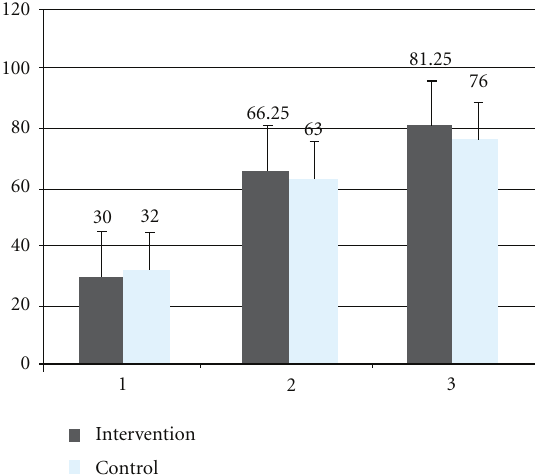
Figure 2: Mean Barthel index scale score at baseline, one month and six months of the intervention and control group. 1; baseline, 2; one month, 3; six months, BI scores range from 0 to 100, with lower scores indicating increasing